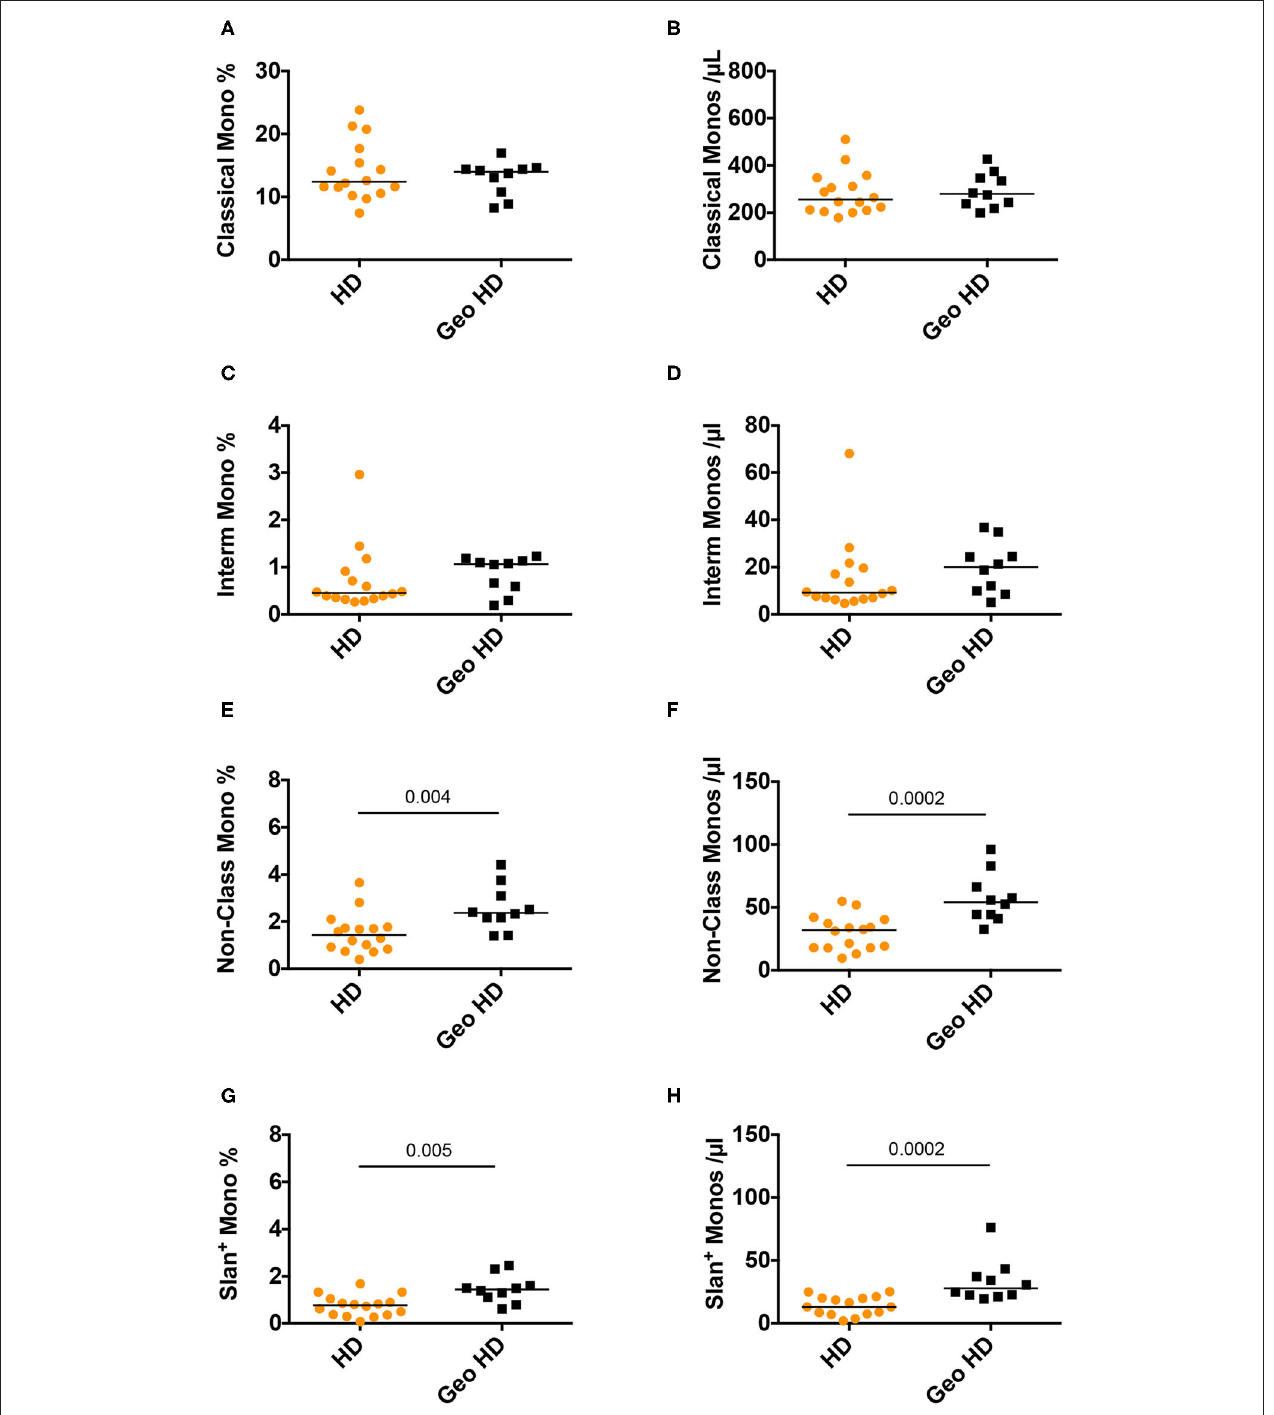
FIGURE 1 | Monocyte subset percentages among CD45 + PBMC and absolute counts in controls from the blood bank (HD) compared to controls of West-African origin (GeoHD). (A) Classical monocyte (CD14 ++ CD16 − ) percentages among CD45 + PBMC and (B) absolute counts/ µ L blood, (C) intermediate monocyte CD14 + CD16 + percentages and (D) absolute counts / µ L blood, (E) non-classical monocyte (CD14 ± C D16 + ) percentages and (F) absolute counts, (G) slan + monocyte percentages and (H) absolute counts, in the two groups of age- and sex- matched healthy donors residing in the Paris area, one from the French Blood Bank (EFS) (HD) and the other of West-African origin (GeoHD). Orange: unknown origin, Black: West-African origin. Horizontal bars represent median values. Mann-Whitney’s post-test p are represented above the horizontal line connecting the compared groups. Kruskall-Wallis tests and descriptive statistics can be found in Table 2 (in italics for West-African